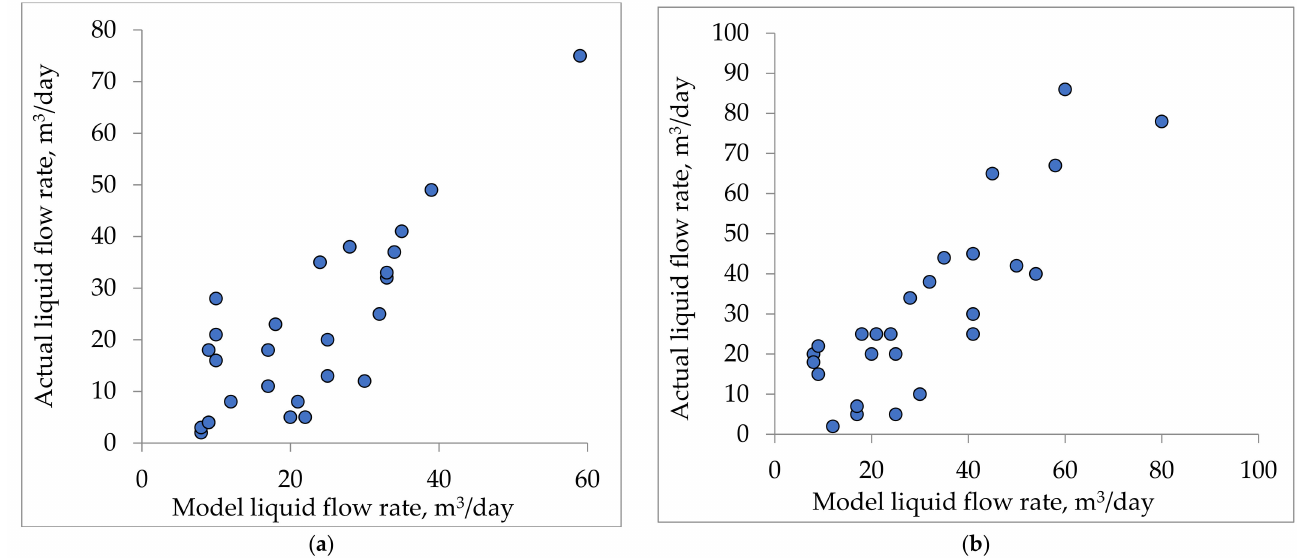
Figure 2. The correlation fields between the actual and model values of the liquid flow rates differentially depend on the values obtained by processing the data of the pressure build-up curve ( a ) and DCA ( b ) (carbonate deposits)